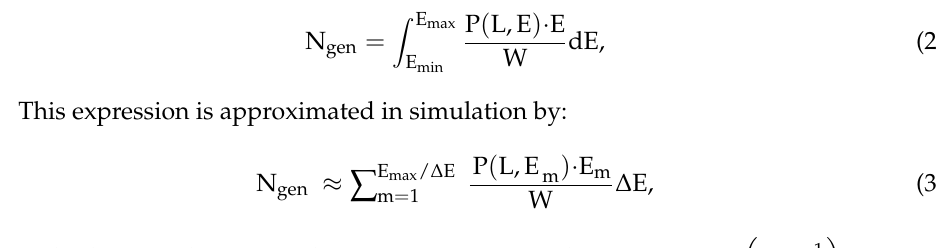
Figure 4. ( a ) The number of photoelectrons generated with 50 keV incident photons, 5–200 µm Si, and 0.1–5 µm PbTe. ( b ) The simulation using 20–50 keV photons, 50 µm Si, and 0.1–5 µm PbTe. The simulation was also performed using 50 µm thick Si, 0.1–5 µm thick PbTe, and 20–50 keV incident X-rays, illustrated in Figure 4b. The number of photoelectrons gener- ated decreases with increasing incident photon energy since higher-energy photons are not down-converted as efficiently by the PAL. Despite the optimal thickness of PbTe oc- curring at 0.5 µm in the limited number of simulation runs, as indicated by the fold in the Figure, the number of pairs does not decrease as expected. Instead, there is a dip at 1 µm PbTe before increasing at 1.5 µm PbTe to be comparable to the 0.5 µm results. The 0.5 µm PbTe yields more higher-energy photons while the 1.5 µm thick PbTe produces more lower-energy photons that generate a similar number of photoelectrons. The 1 µm PbTe in turn yields fewer higher-energy photons than 0.5 µm PbTe and fewer lower-energy photons than the 1 µm PbTe, resulting in the decline. Additionally, the number of photoelectrons generated before impact ionization di- vided by the number of incident photons, called the quantum yield (QY), is a useful pa- rameter to compare to existing technologies. The QY of 1 µm PAL, 20 keV X-rays, and 50 µm Si is ~20%, much greater than the <5% using the silicon direct detection method [3,12].